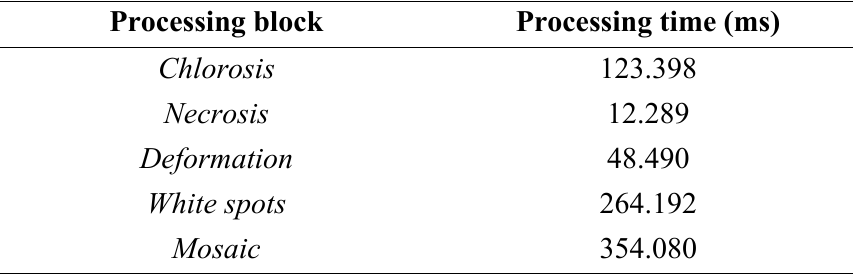
Table 1. Processing times of the blocks implemented in the